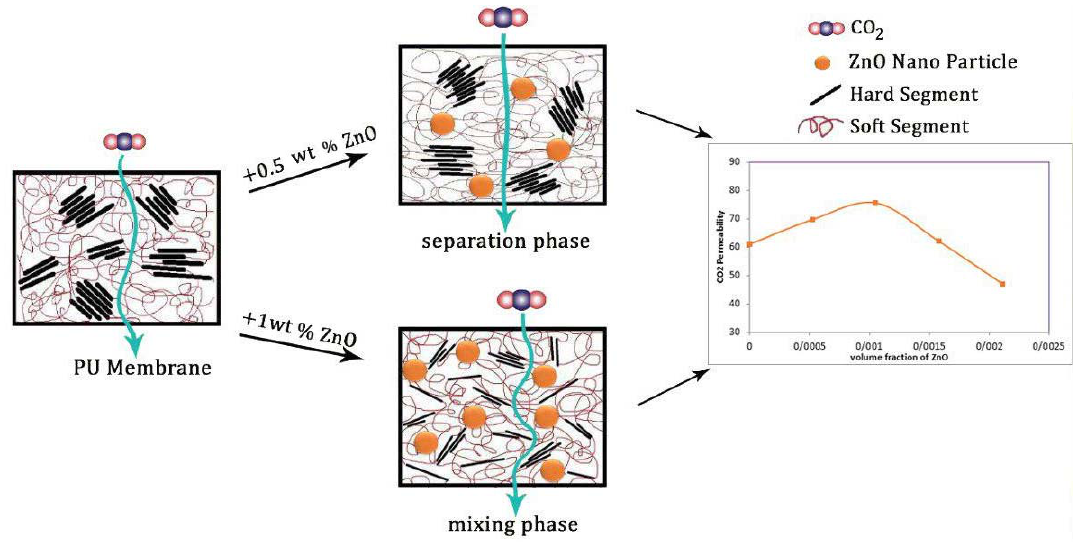
Figure 6. ( a ) CO 2 ; ( b ) CH 4 and ( c ) N 2 permeabilities through the MMMs vs. pressure; ( d ) pure gas permeabilities of PU ‐ ZnO 0.5 wt %.